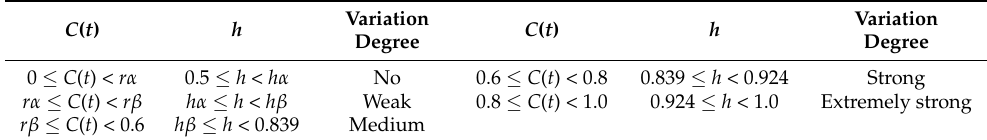
Table 1. Variation degree analysis.